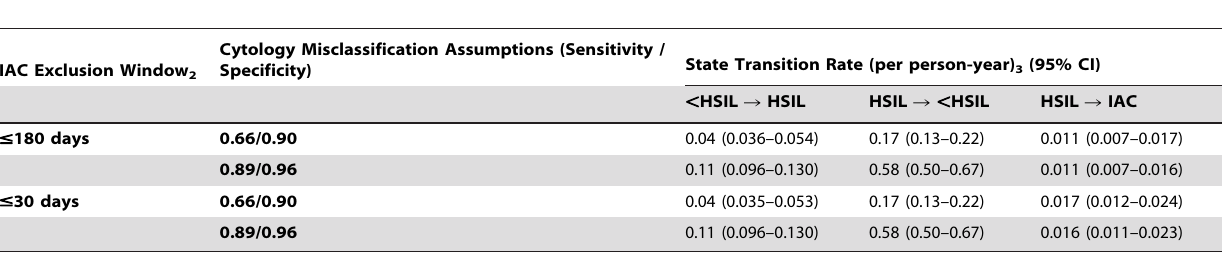
Table 3. Estimates of State Transition Rate (per person-year) adjusted for Cytology Misclassification Assumptions, by IAC-Exclusion Window ( # 180 vs. # 30 days) 1 .